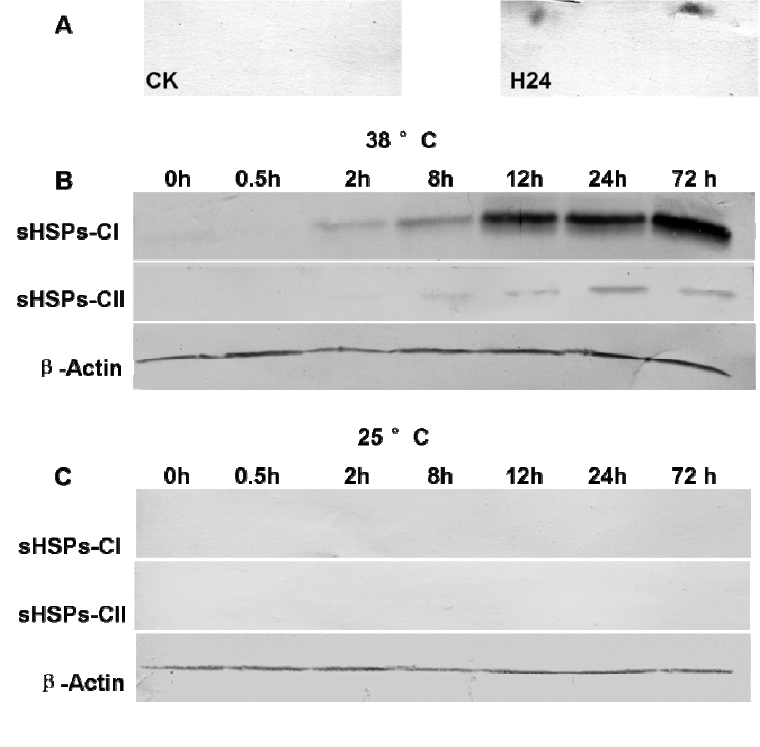
Figure 6. Protein level changes for sHSPs-CI and sHSPs-CII in P. ternata leaves exposed to heat stress. ( A ) 2-DE Western blot analysis of sHSPs-CII proteins in P. ternata leaves. The total proteins extracted from the unstressed (CK) or stressed samples at 24 h (H24) were separated by 2-DE. The portion of the gel corresponding to 12–18 kDa and pI 5.2–5.8 was excised; ( B ) Accumulation of sHSP-CI and sHSPs-CII proteins in the leaves of P. ternata induced by exposure to 38 °C; and ( C ) Accumulation of sHSP-CI and sHSP-CII proteins in the leaves of P. ternata maintained at 25 °C. Equal amounts (15 mg) of total protein were loaded onto sodium dodecylsulfate-polyacrylamide gel electrophoresis gels. The levels of sHSPs-CI, sHSPs-CII and actin proteins were estimated by immunoblotting, as described in the Materials and Methods